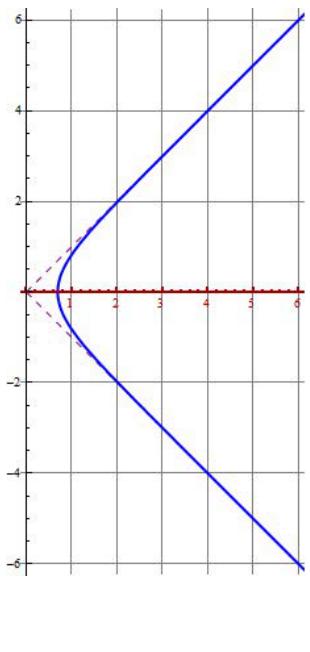
Fig. 18. Spacelike curve with K( y ) = sinh y